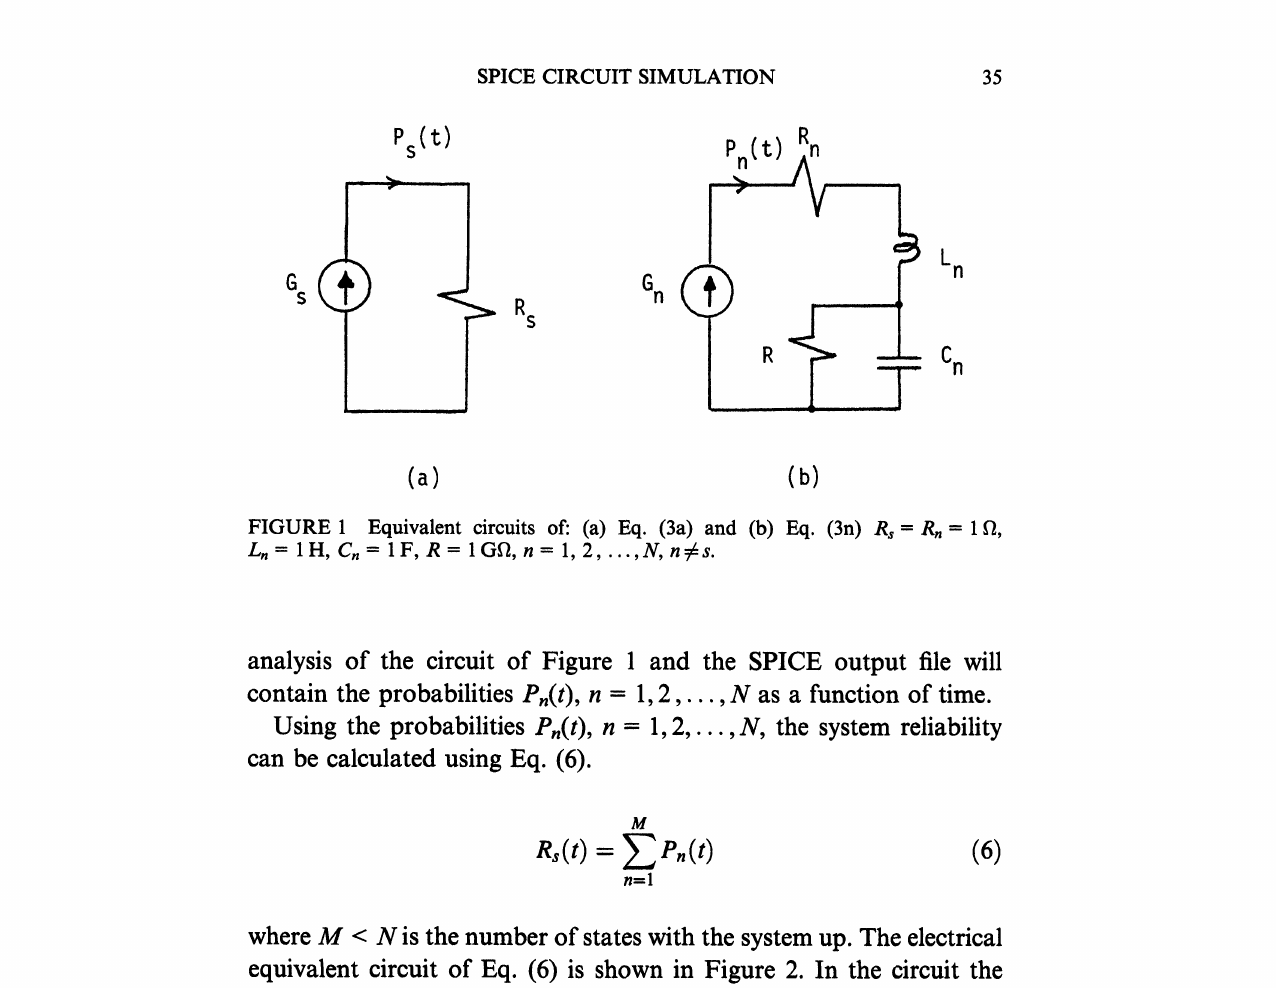
analysis of the circuit of Figure and the SPICE output file will contain the probabilities P,(t), n 1, 2,..., N as a function of time. Using the probabilities P,(t), n 1,2,... ,N, the system reliability can be calculated using Eq.